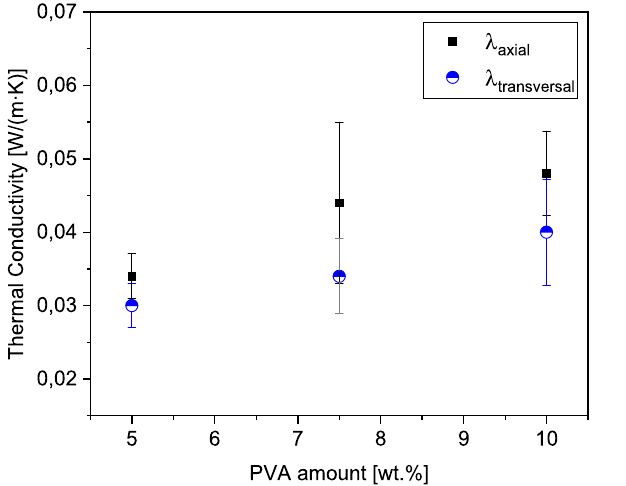
Figure 2. Calculated thermal conductivities of the pure PVA scaffolds in dependency of the PVA amount.